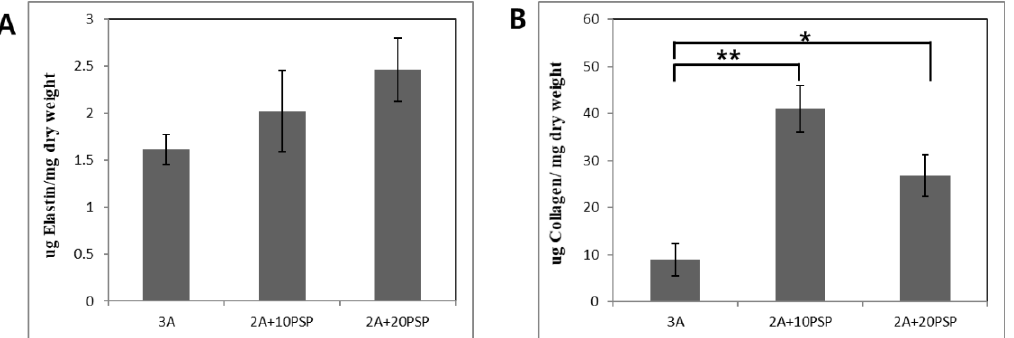
Figure 5. Quantitative analysis of the ECM components. Elastin contents ( A ) and collagen contents ( B ) results of the cells printed structures after 7 days of incubation. The statistical significance of differences between the 3% alginate hydrogel (3A) and PSP-inks in 2% alginate (2A+10PSP, 2A_20PSP) groups were assessed using one-way ANOVA. * p < 0.05 and ** p < 0.01.